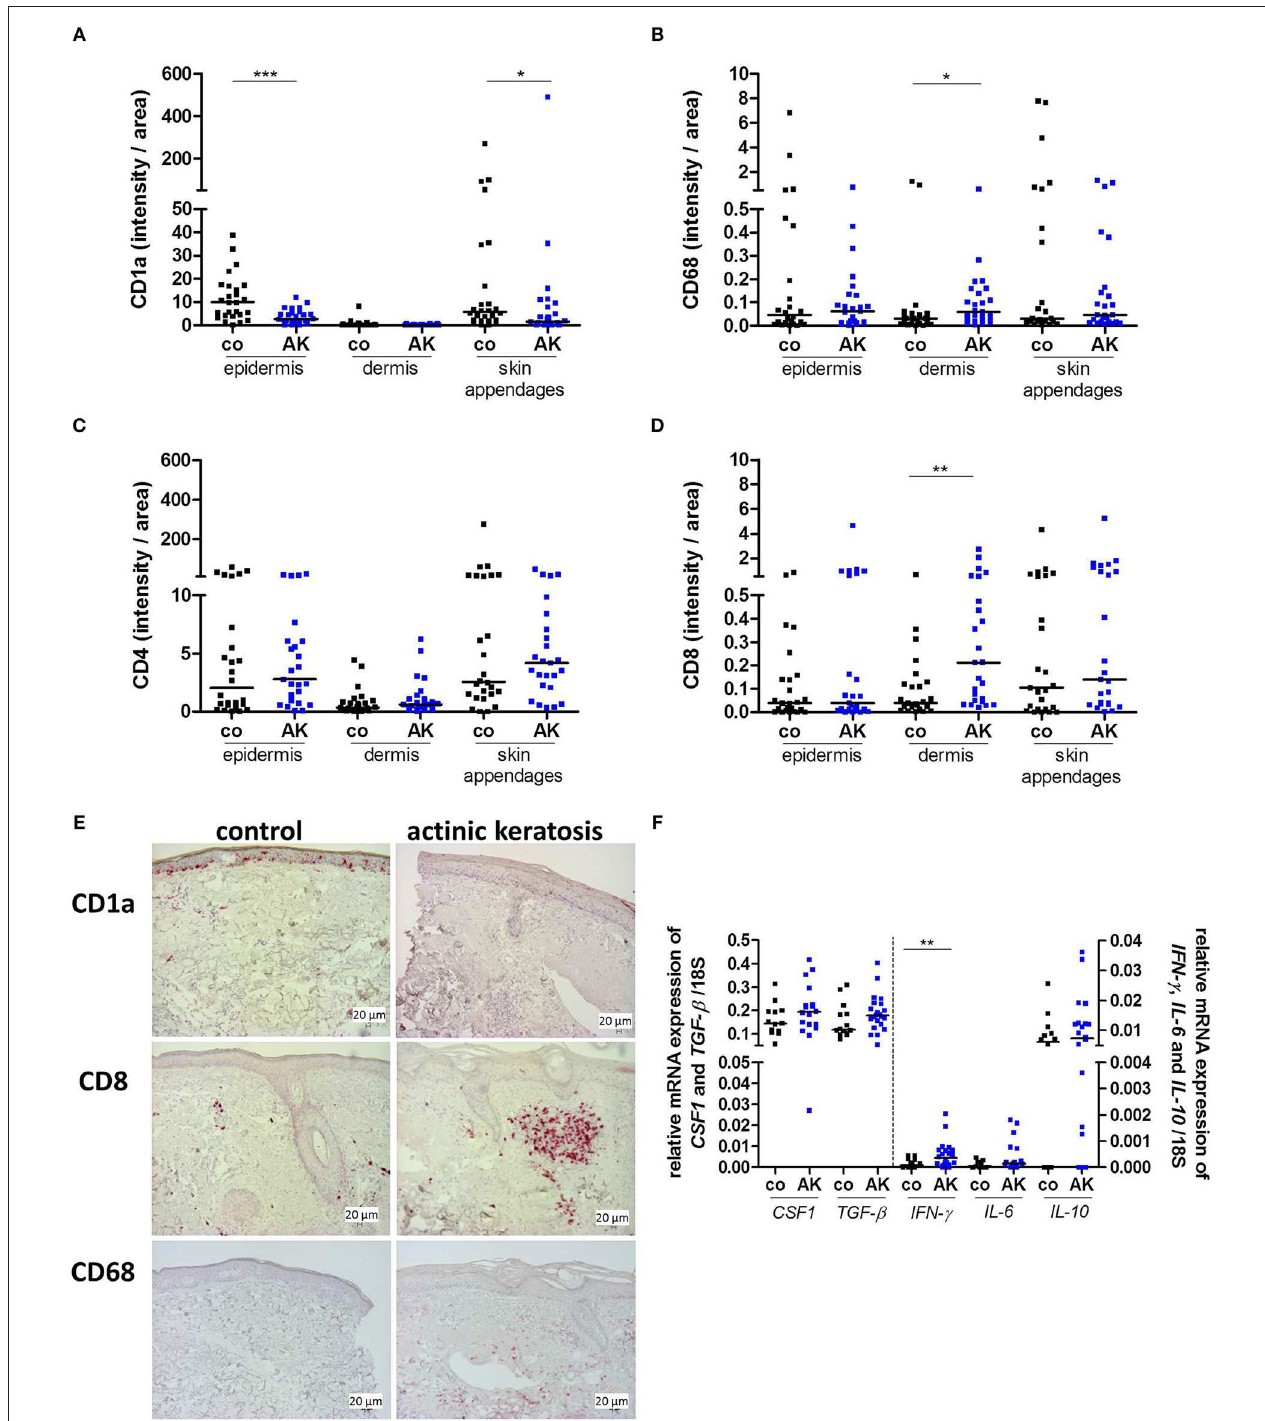
FIGURE 3 | Actinic keratosis induces changes in the skin immune infiltrate. (A–D) Immunohistochemical staining of (A) CD1a, (B) CD68, (C) CD4, and (D) CD8 in epidermis, dermis and skin appendages in actinic keratosis lesions (AK) and control biopsies (co) of sun-exposed, untreated, healthy skin in 28 patients. The selected pixels of the evaluated images were expressed as the percentage of the total area. (E) Representative stainings of CD1a (upper images), CD8 (middle images), and CD68 (lower images) in actinic keratosis lesions and control biopsies. (F) qRT-PCR analysis of CSF1 , TGF- β , IFN- γ , IL-6, and IL-10 gene expression in actinic keratosis lesions and control skin biopsies. The dark lines indicate the median. * p < 0.05, ** p < 0.01, *** p < 0.001 (Mann-Whitney test).